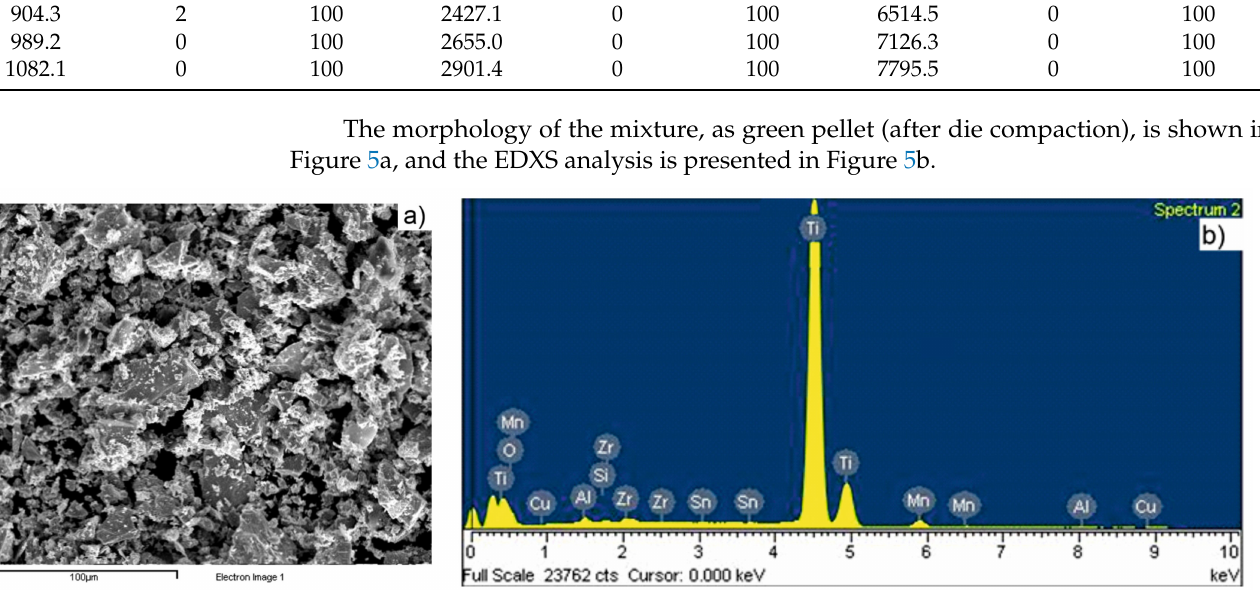
Figure 5. The mixture based on TiH 2 powder: ( a ) SEM image and ( b ) EDXS spectrum. In Figure 6, the dispersion mode of each component of the mixture is shown using elemental mapping of green compact. The massive dispersion of titanium powder can be observed, while Cu powder is uniformly dispersed in the mass of the mixture. However, small agglomerations appear for Mn and Zr